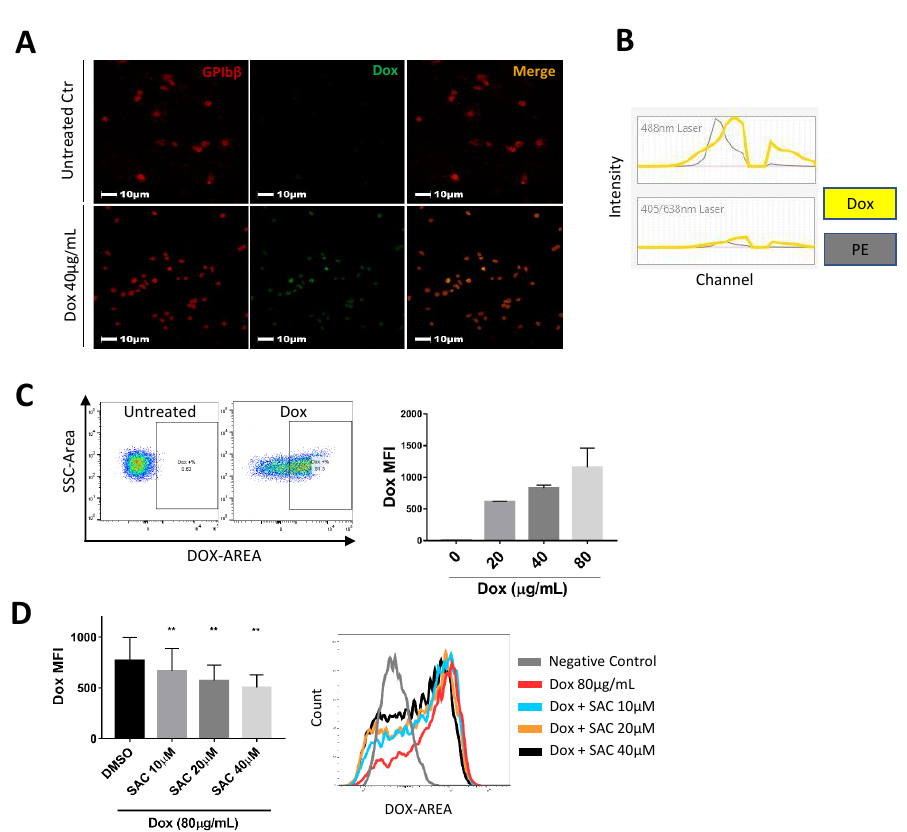
Figure 4. SAC Reduces Dox Uptake by Platelets. ( A ) Confocal imaging visually depicts platelet intake of Dox following incubation. Murine platelets labelled with AlexaFluor-647-conjugated anti-GPIb β antibody (red, left column) were untreated (upper row) or incubated with Dox (lower row). Dox exhibited autofluorescence ~590nm (Green, middle column). Representative images taken from 3 independent experiments, scale bars = 10 µ m. ( B ) Unique Dox spectral signature across all channels determined from spectral cytometer. ( C ) Dose-dependent uptake of Dox by platelets quantified by Dox MFI (right), and representative population shift for platelets exhibiting Dox signal following incubation with 40 µ g/mL Dox (left). ( D ) SAC dose-dependently reduced Dox permeation of platelets. Data are displayed as mean ± SD. n ≥ 3 for all experiments. Statistical significance determined by one-way ANOVA. (** p <